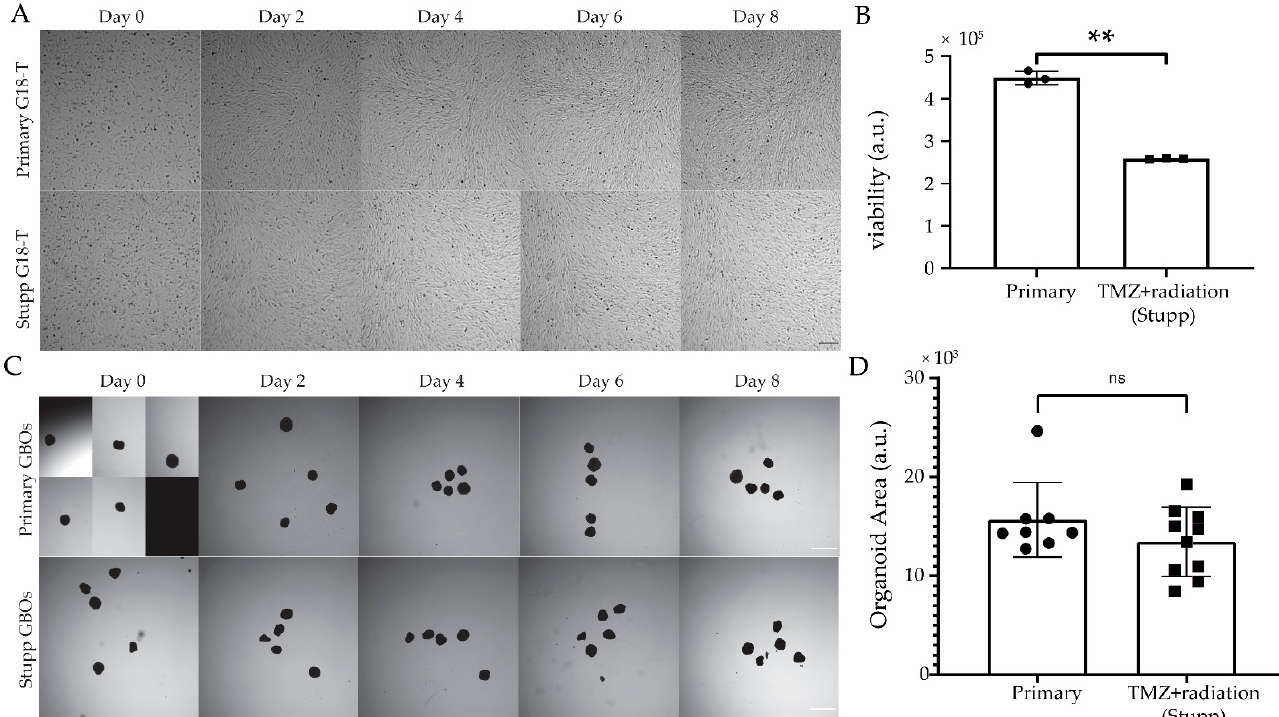
Figure 5. Resistance to standard of care treatment “in a dish” in 2D cultures of GSC and in GBOs. ( A ) Brightfield images of primary G18-T (untreated) and Stupp G18-T (temozolomide (TMZ)+radiation treated) 2D cell cultures over the 8-day treatment period. Day 0 images were taken immediately before treatment (Scale bar 300 µm). ( B ) Cell viability measured at the end of the protocol using CellTiter-Glo ® 2.0 bioluminescence assay. ( C ) Brightfield images of Primary GBOs (untreated) and Stupp GBOs (TMZ+radiation treated) over the 10-day treatment period, with Day 0 images taken immediately before treatment (Scale bar 1 mm). ( D ) 2D area of GBOs at Day 10 for each treatment condition. All images were processed using ImageJ with consistent settings applied for all images. Data are mean ± SEM, n = 4 (B), n = 10 ( D ); **, p < 0.01; ns, not significant, two tailed, t -test.